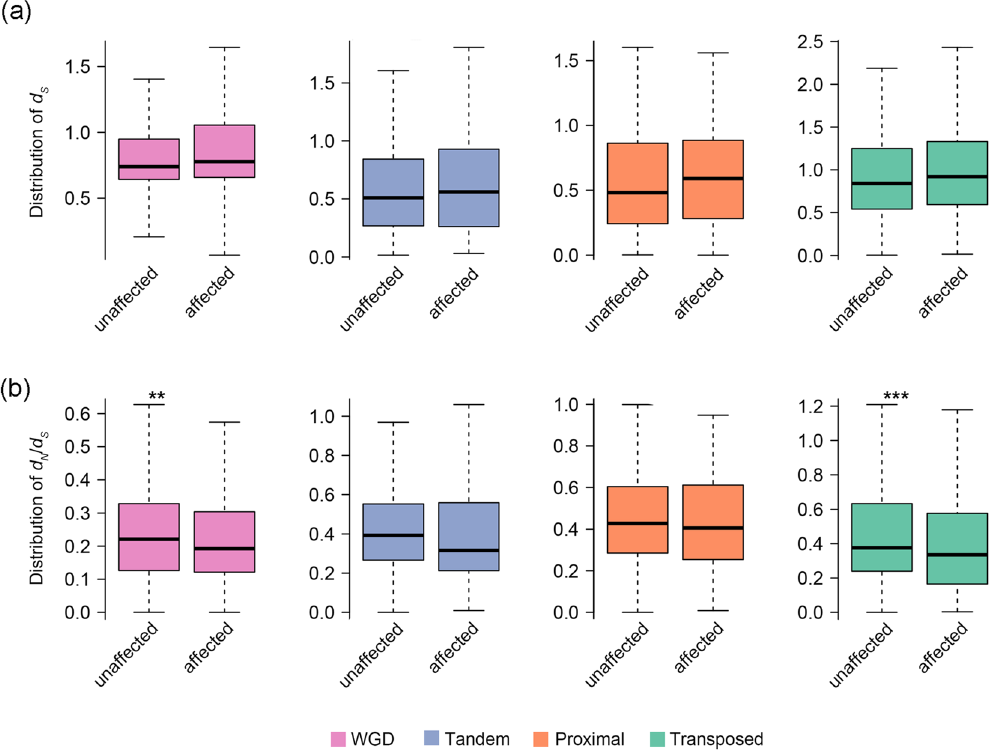
Figure 4. Comparison of distributions of d S ( a ) and d N /d S ( b ) between expression-unaffected and -affected duplicates of each of the four categories with CG-only methylation due to loss of BCGM. The Kolmogorov- Smirnov test was conducted for statistical significance. There were no significant changes in d S distribution for any duplication category (K-S test, p values > 0.05), but the ranges of d N /d S distribution were significantly larger in expression-unaffected duplicates than expression-affected duplicates (K-S test, p values < 0.01) in the WGD and transposed